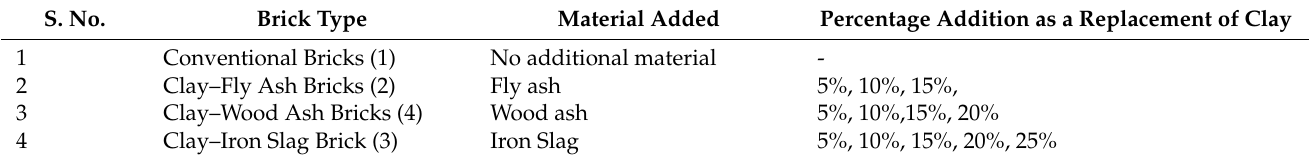
Table 2. Brick types and percentage addition of fly ash, wood ash, and iron slag.